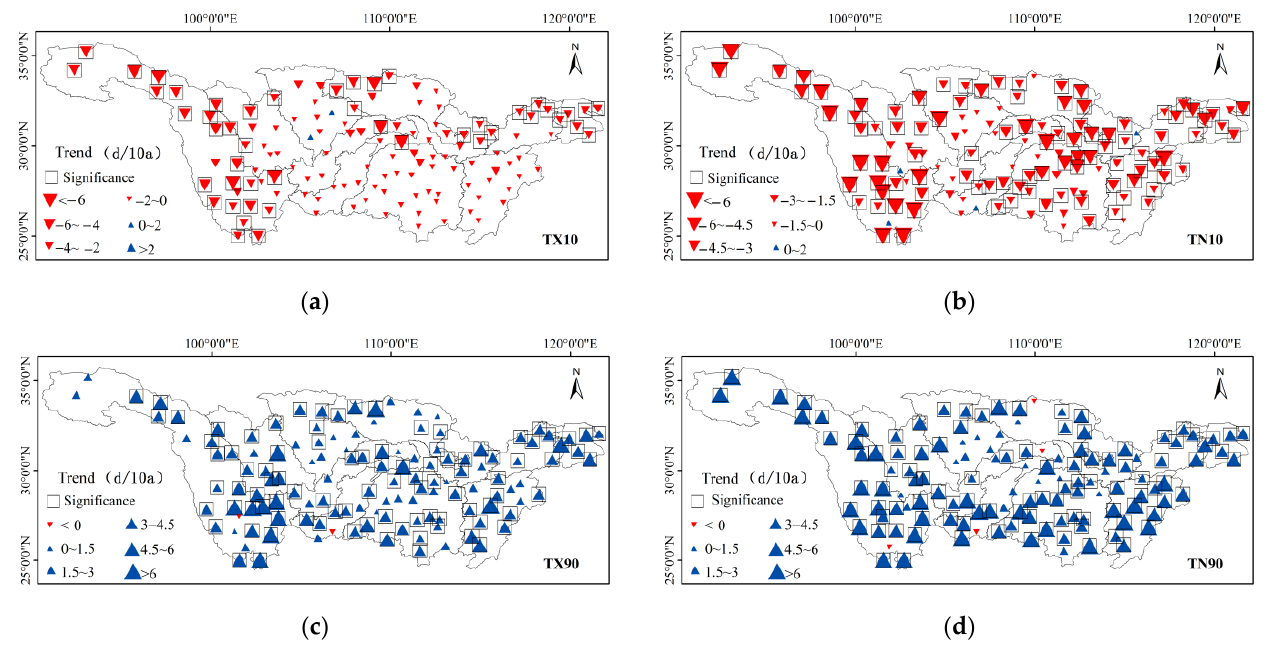
Figure 3. Spatial distribution of interannual variability of relative indices of extreme temperature in the Yangtze River Basin from 1970 to 2014. ( a ) is TX10, ( b ) is TN10, ( c ) is TX90 and ( d ) is TN90.